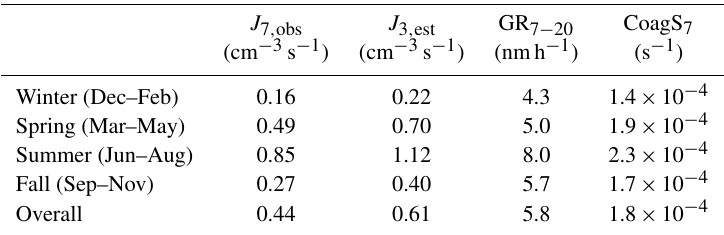
Figure 1. Comparison of the estimated ( J 3 , est ) against observed ( J 3 , obs ) formation rates of 3nm particles during the selected new particle formation (NPF) event days in Hyytiälä. (a, c) Formation rates J 3 , est and J 3 , obs calculated at 10min time resolution between 07:00 and 19:00. Note that the time lag during which particles grow from 3 to 7nm is taken into account in the J 3 , est . (b, d) Arithmetic mean of formation rates between 07:00 and 19:00 local time for each NPF day. Panels in the top row refer to J 3 , est results calculated using GR 3–10 and the bottom row to those calculated using GR 7–20 . The black lines show the bivariate linear fits to the logarithmic data values; the corresponding parameter values of the fit equations J 3 , est = a · J b and the correlation coefficients r are given in each panel. The values in square brackets 3 , obs show the 5th and 95th percentile bootstrap confidence intervals of the parameter values. The fractions of J 3 , est that are within factor of 2 of J 3 , obs are shown in the upper left corner of each subplot (for the 10min time resolution data also data points within fraction of 3 and 4 are shown). Table 1. Overall and seasonal mean values of the observed formation rates of 7nm particles ( J 7 , obs ) , the estimated formation rates of 3nm particles ( J 3 , est ) , the growth rates of particles in size range 7–20nm (GR 7–20 ) , and the coagulation sink of 7nm particles onto larger particles (CoagS 7 ) for 105 NPF days which occurred at Puijo during April 2007–December 2015. The J 7 , obs , J 3 , est , and CoagS 7 include data during 07:00–19:00 on each NPF